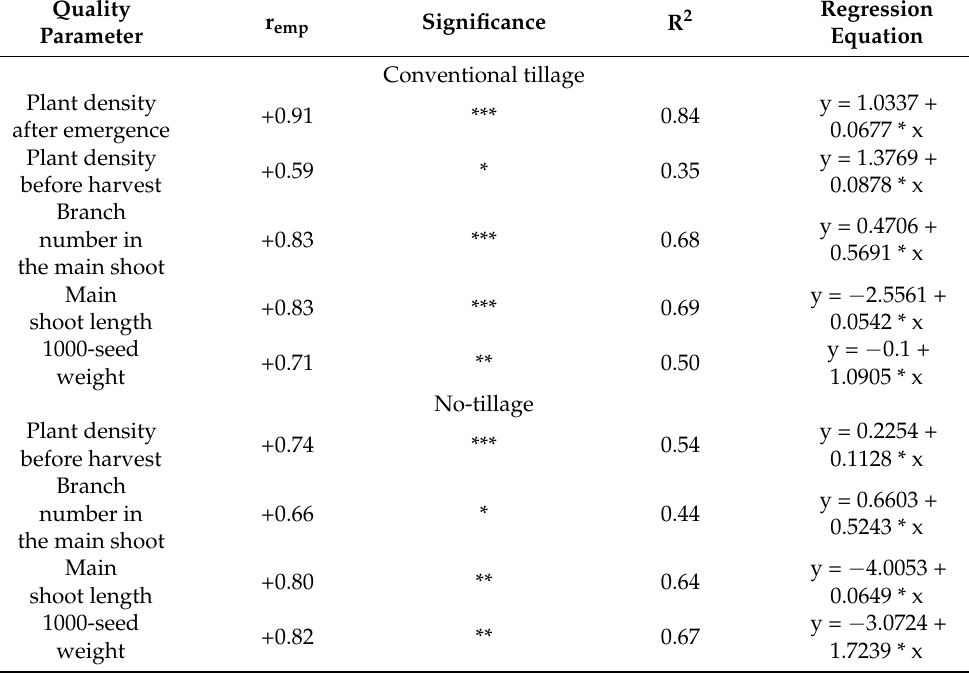
Regression Equation